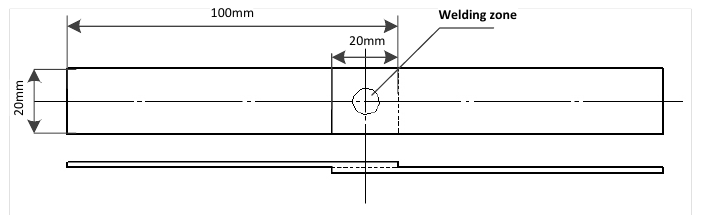
Figure 1. Dimensions of the sample.